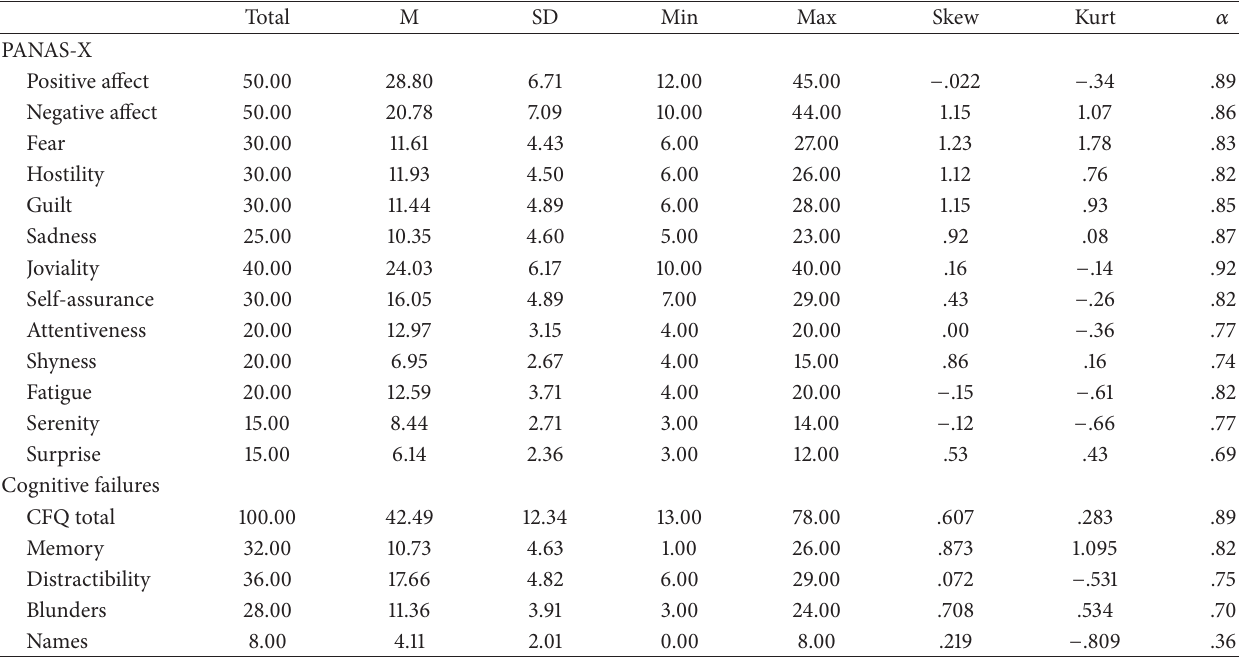
Table 2: Descriptive statistics for total scores on PANAS-X and CFQ factors.